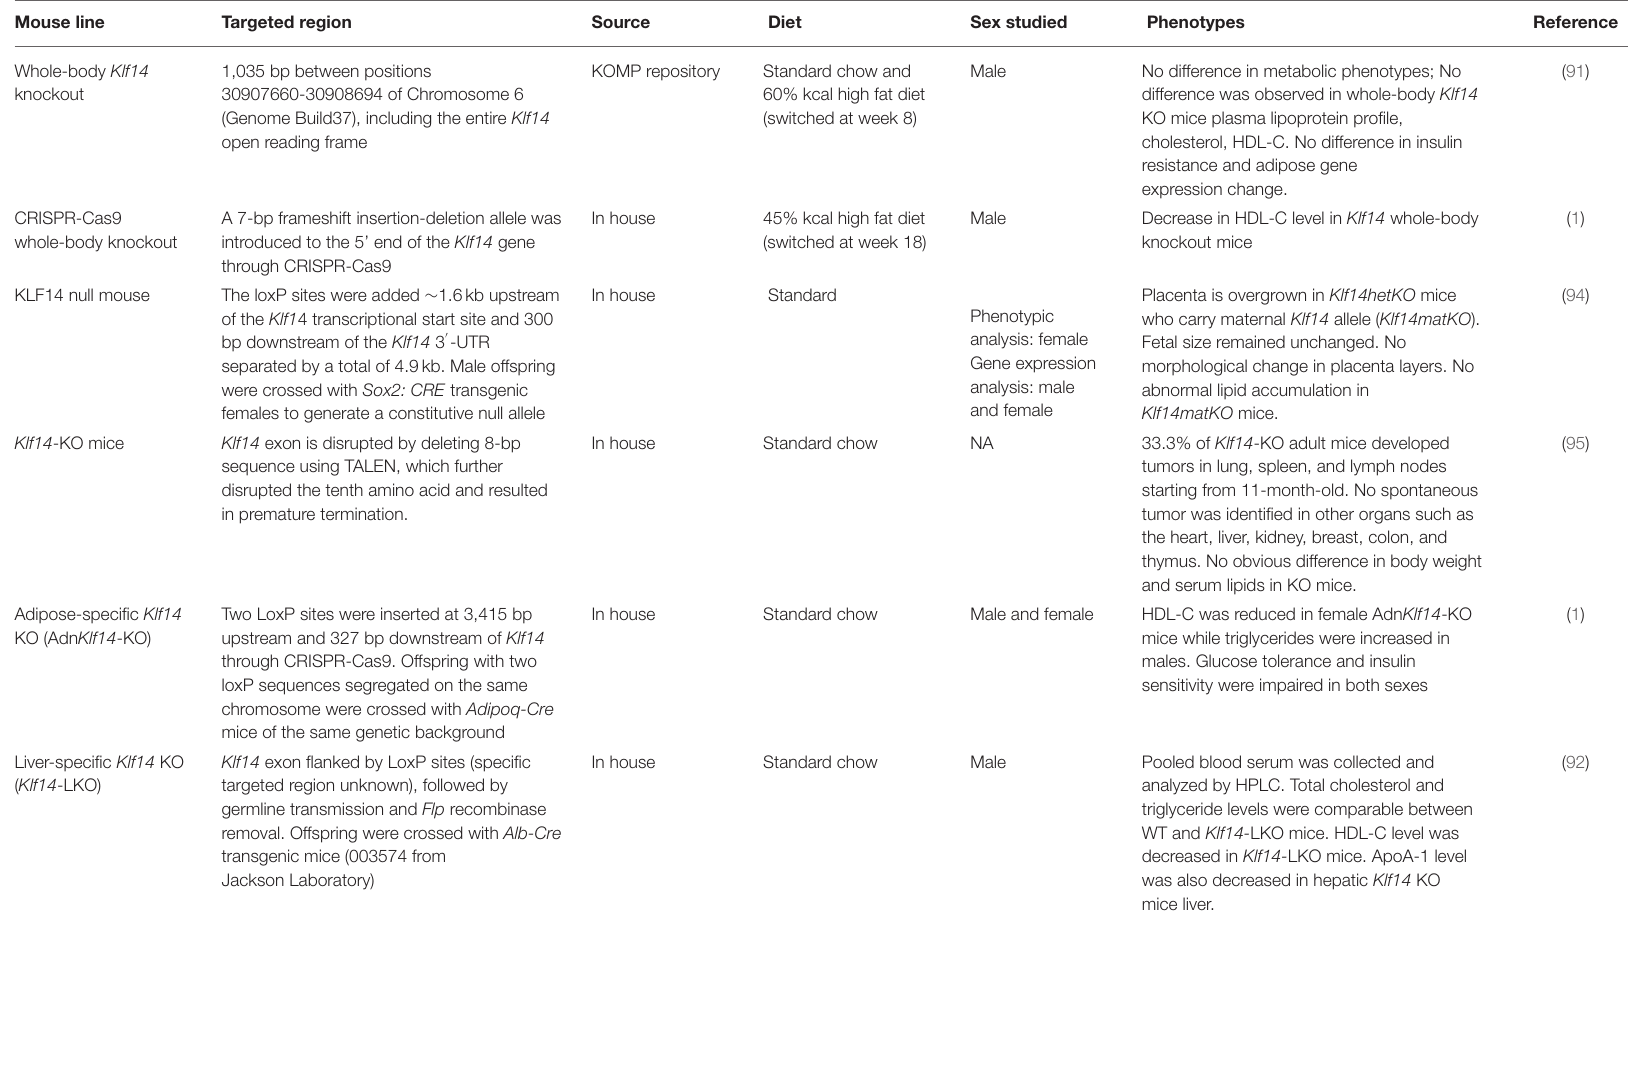
TABLE 2 | Summary of published KLF14 mouse lines. Mouse